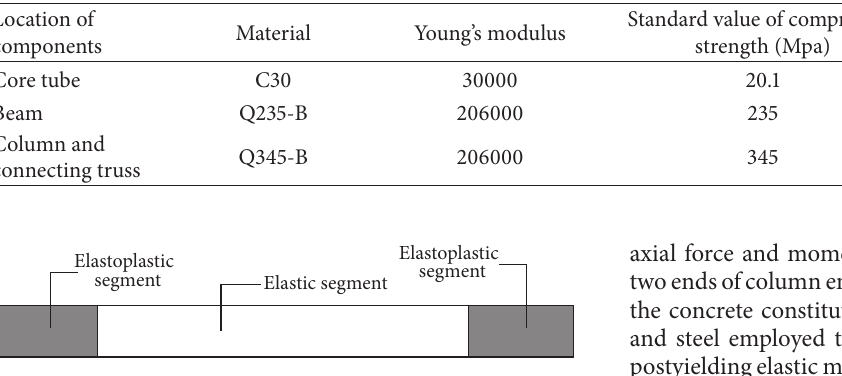
Figure 5: The frame element composed of three stiffness segments.